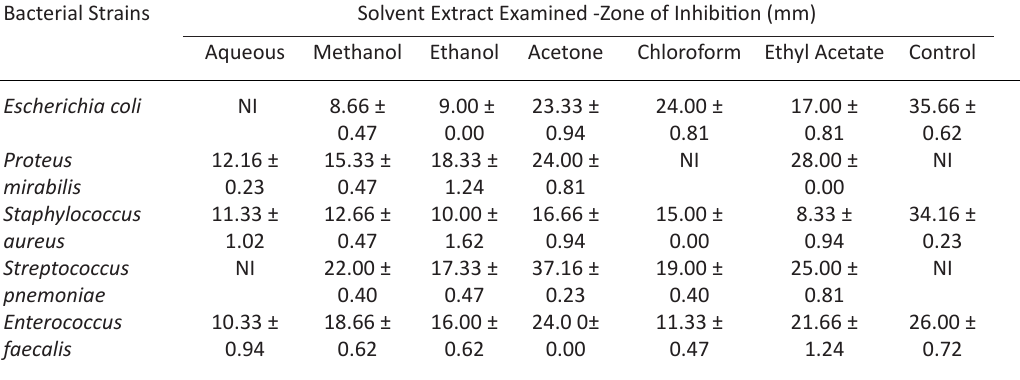
Table 1. Inhibitory Activity of Laurus nobilis Solvent Extracts Against Pathogenic Bacterial Strains Solvent Extract Examined -Zone of Inhibition (mm) Aqueous Methanol Ethanol Acetone Chloroform Ethyl Acetate Control Escherichia coli NI Proteus mirabilis Staphylococcus